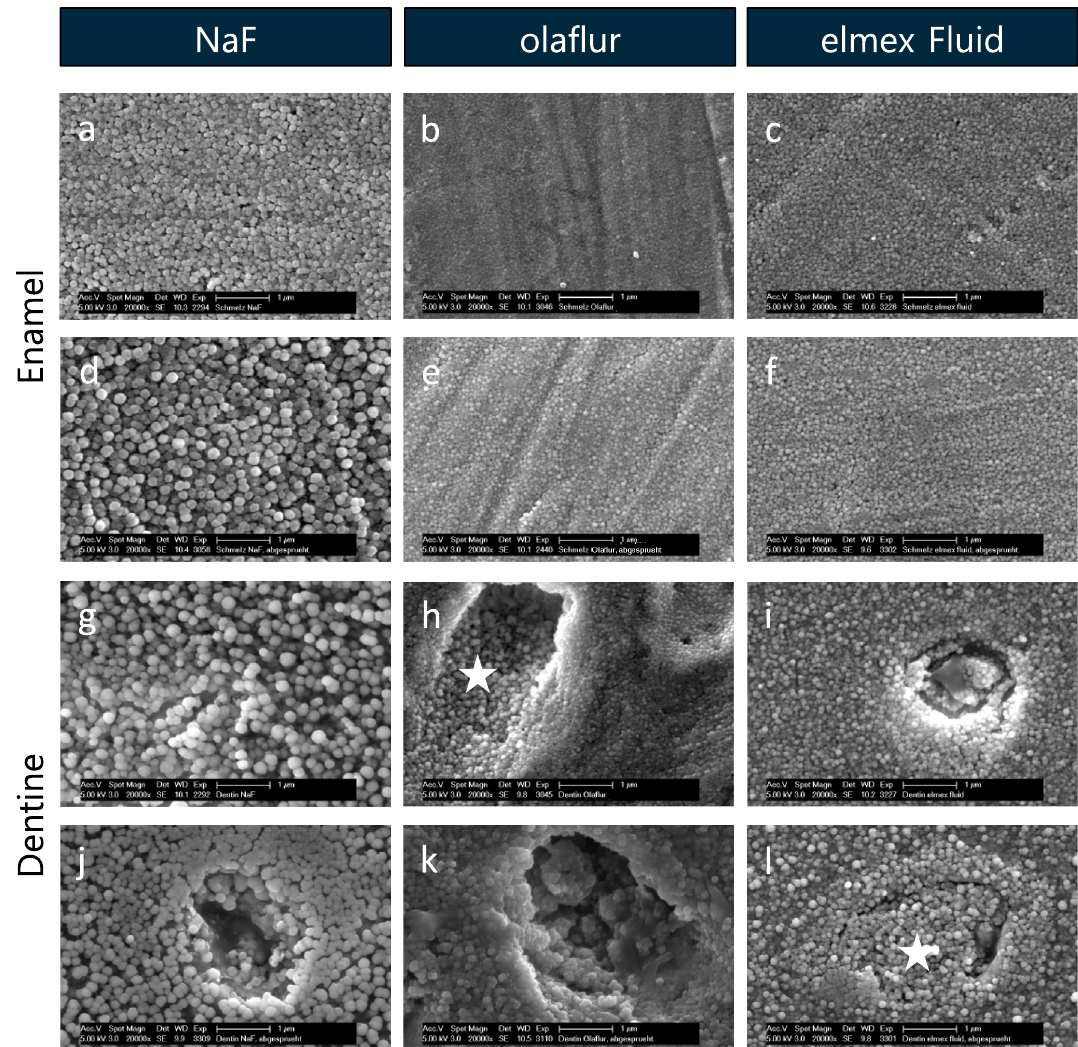
Figure 4. SEM figures at 20,000-fold magnification of enamel ( a–f ) and dentine ( g–l ) samples after 5 min incubation in sodium fluoride ( a,g ), olaflur ( b,h ), elmex Fluid ( c,i ) and subsequent 20 s spraying with the multifunctional syringe ( d–f,j–l ). The images reveal a complete masking of the surface with globular precipitates, even after spraying. White asterisks mark dentine tubules coated with globules. NaF sodium